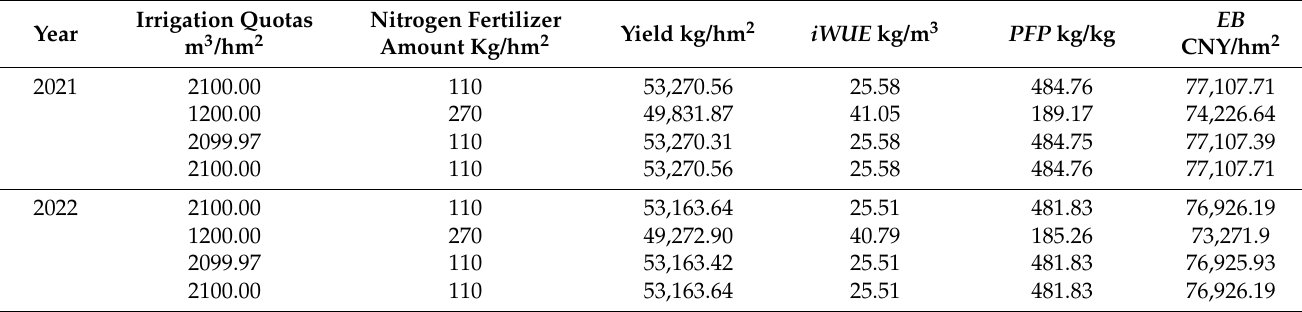
Table 5. Maximum yield, water use efficiency, biased fertilizer productivity, and economic efficiency, and their corresponding irrigation and N application